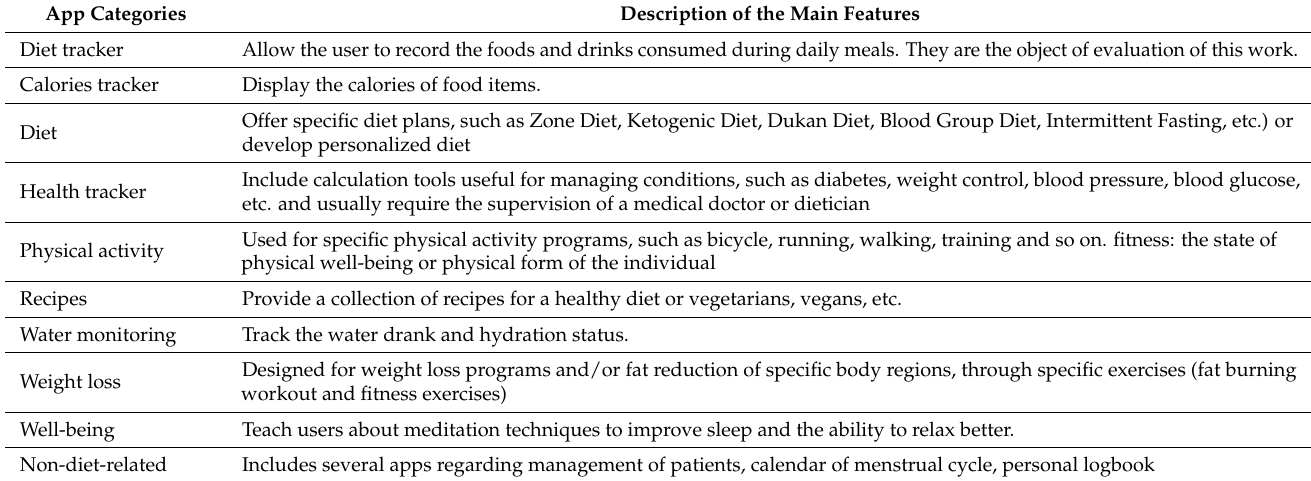
Figure 1. Flowchart of apps research and selection. Table 1. Description of app